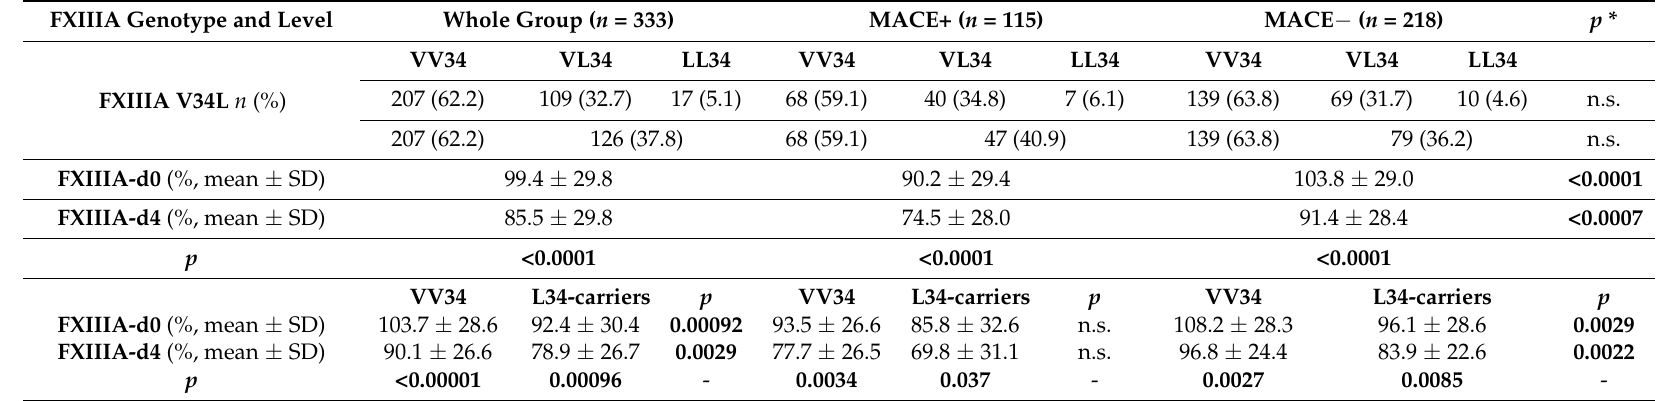
Table 2. FXIIIA levels assessed at admission (d0) and four days after AMI (d4) in the whole group, and in the VV34- and L34-carriers stratified by presence (MACE+) or absence (MACE − ) of major adverse cardiovascular